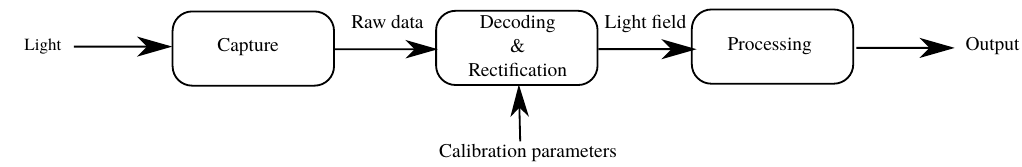
Figure 2. General light-field